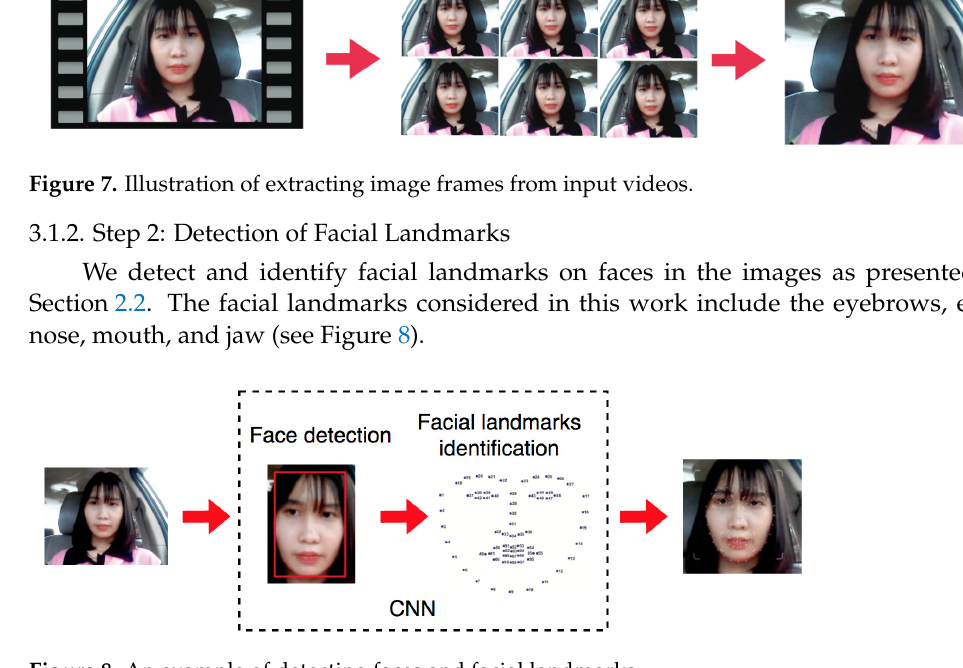
Figure 8. An example of detecting faces and facial landmarks.